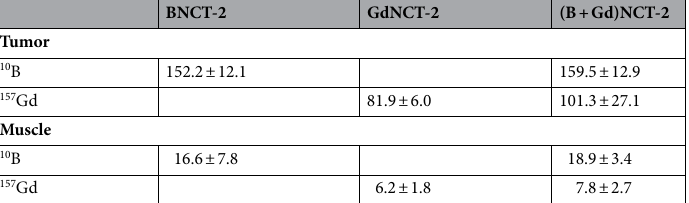
Table 2. Biodistribution of boron and gadolinium concentrations (µg g -1 tissue) in the tumor and muscles of CT26 tumor bearing mice 1 h post-injection determined using inductively coupled plasma atomic emission spectroscopy. Data are presented as mean ± standard deviation (SD) of five